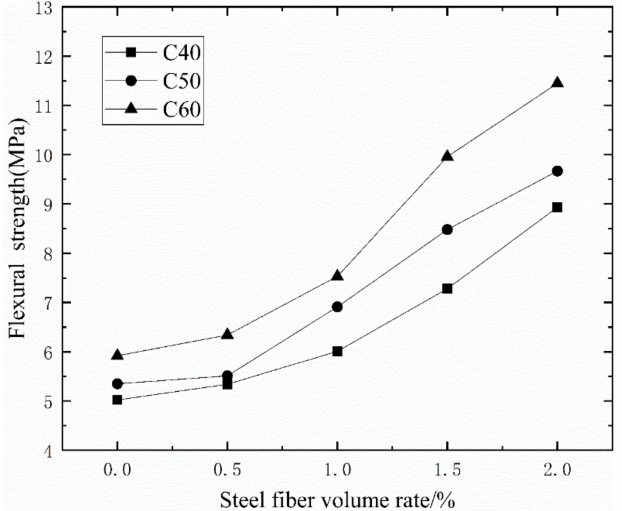
Figure 12. The relationship between the flexural strength of concrete and steel fiber